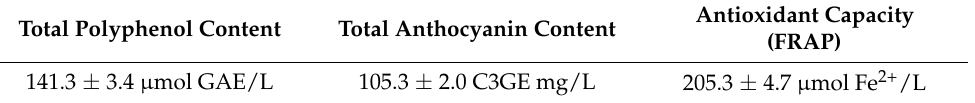
Table 1. Polyphenolic content and antioxidant capacity of blueberry polyphenol extract (BPE). Total Polyphenol